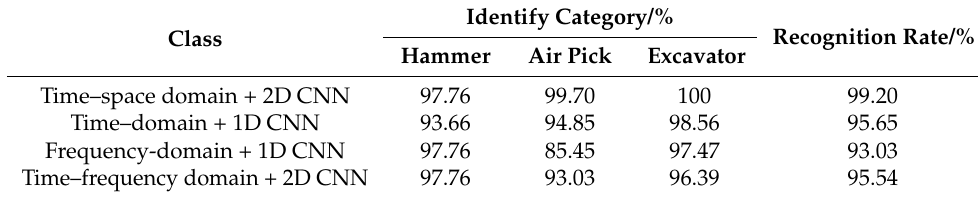
Table 2. The event classification accuracy of Testset2.